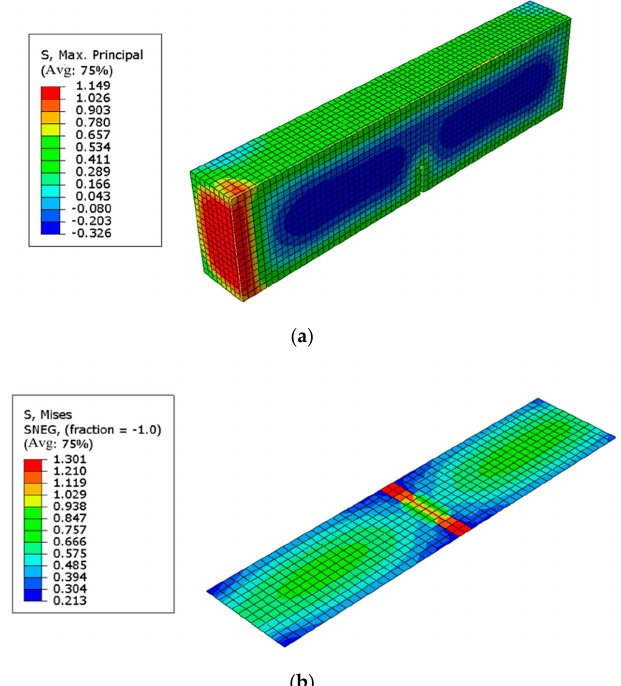
Figure 16. Stress in prismatic model at 99–100 freeze–thaws. ( a ) Stress of concrete; ( b ) stress of fiber cloth.